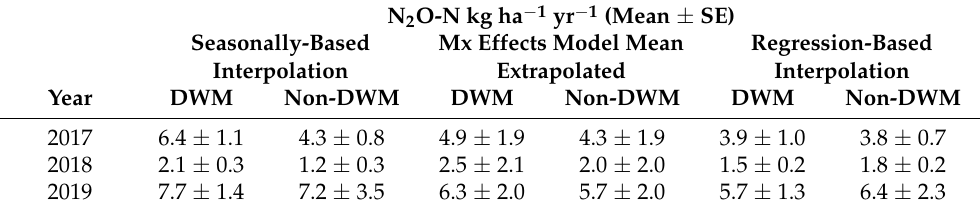
Table 3. Comparison between annual N 2 O flux measurement methods. The SE associated with the seasonally-based interpolation and regression-based interpolation means represent spatial hetero- geneity among chambers. The mixed-effects model mean extrapolation error represents the reported model mean error.